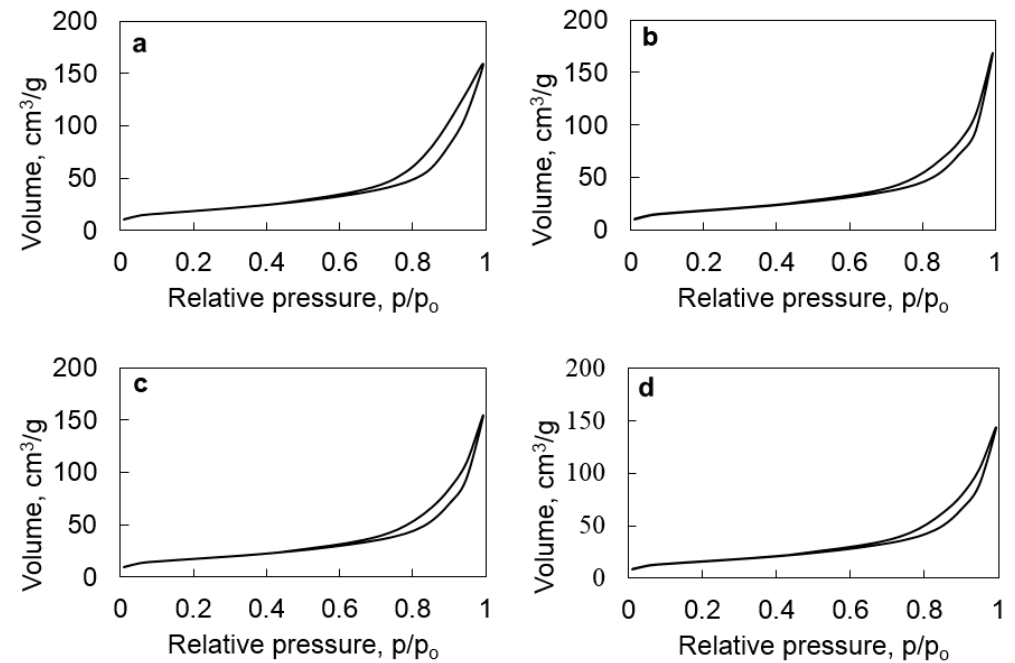
Figure 3. N 2 adsorption–desorption isotherms of HNT ( a ), HNT@Ru-1 ( b ), HNT@Ru-2 ( c ), and HNT@Ru-3 ( d ).